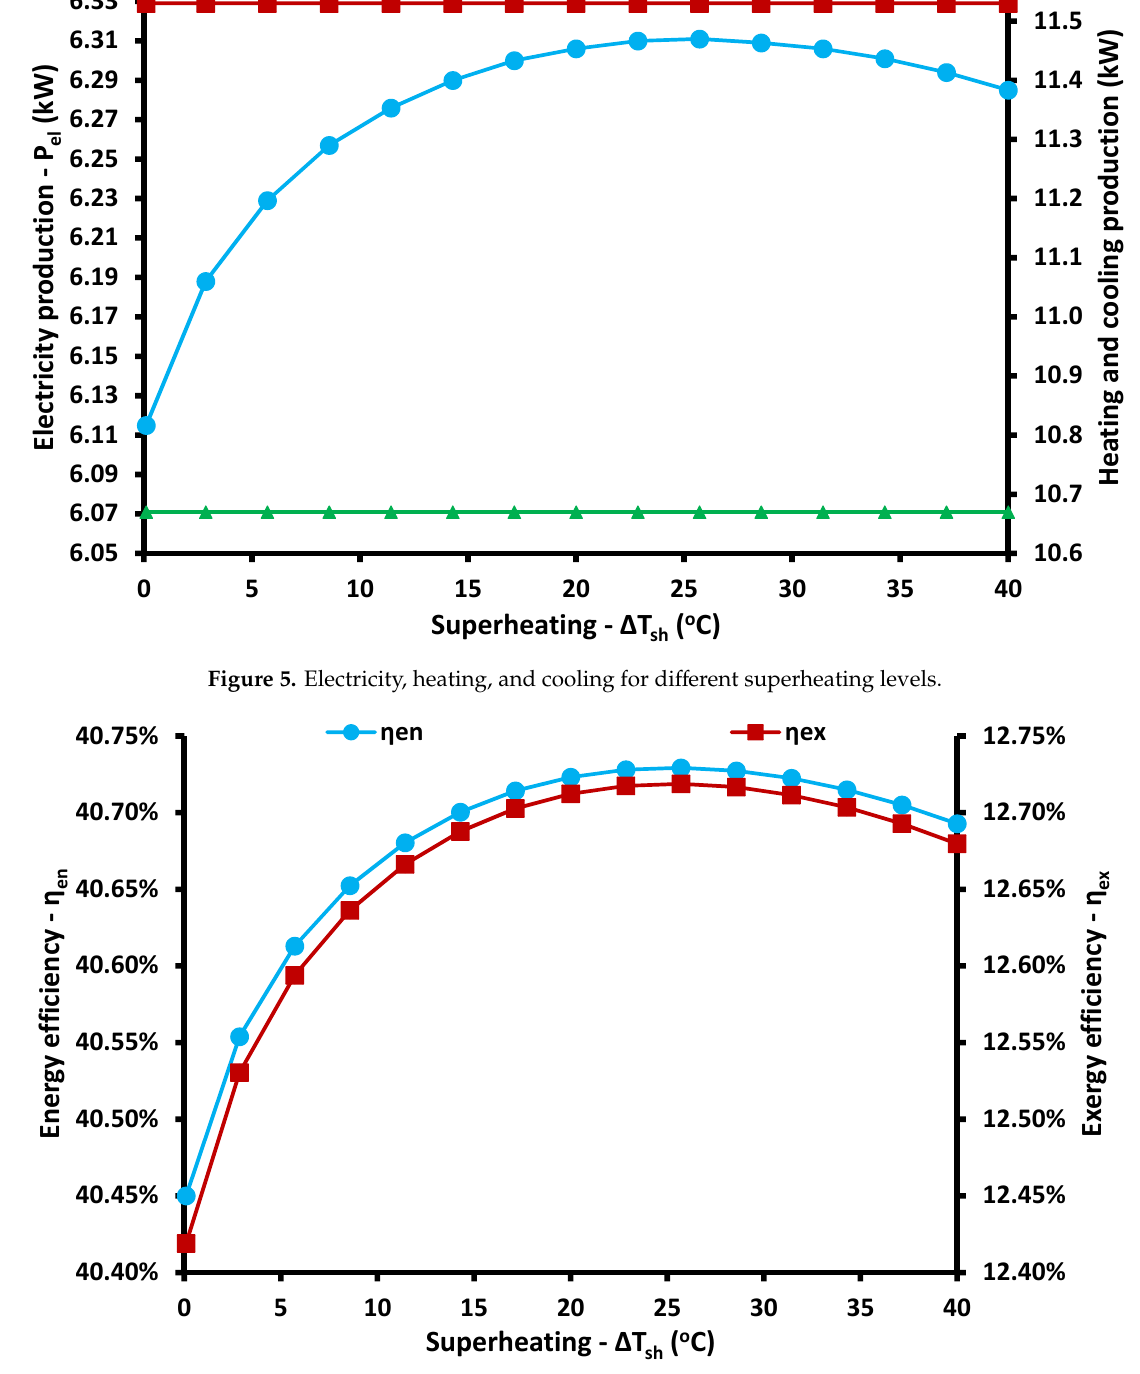
Figure 6. Energy and exergy efficiency for different superheating levels.